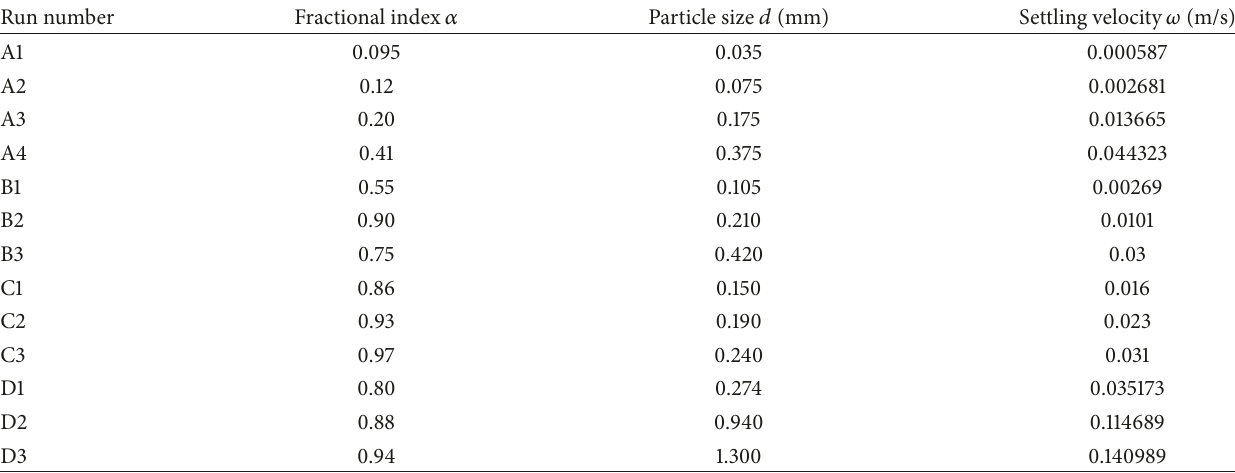
Table 2: The best fit fractional index 𝛼 in the fADE model and corresponding hydraulic parameters, 𝑑 -the particle size, and 𝜔 -the settling velocity. Here, “A” denotes Chen et al. [21], “B” denotes Coleman [25], “C” denotes Lyn [26], and “D” denotes Einstein and Chien [27].